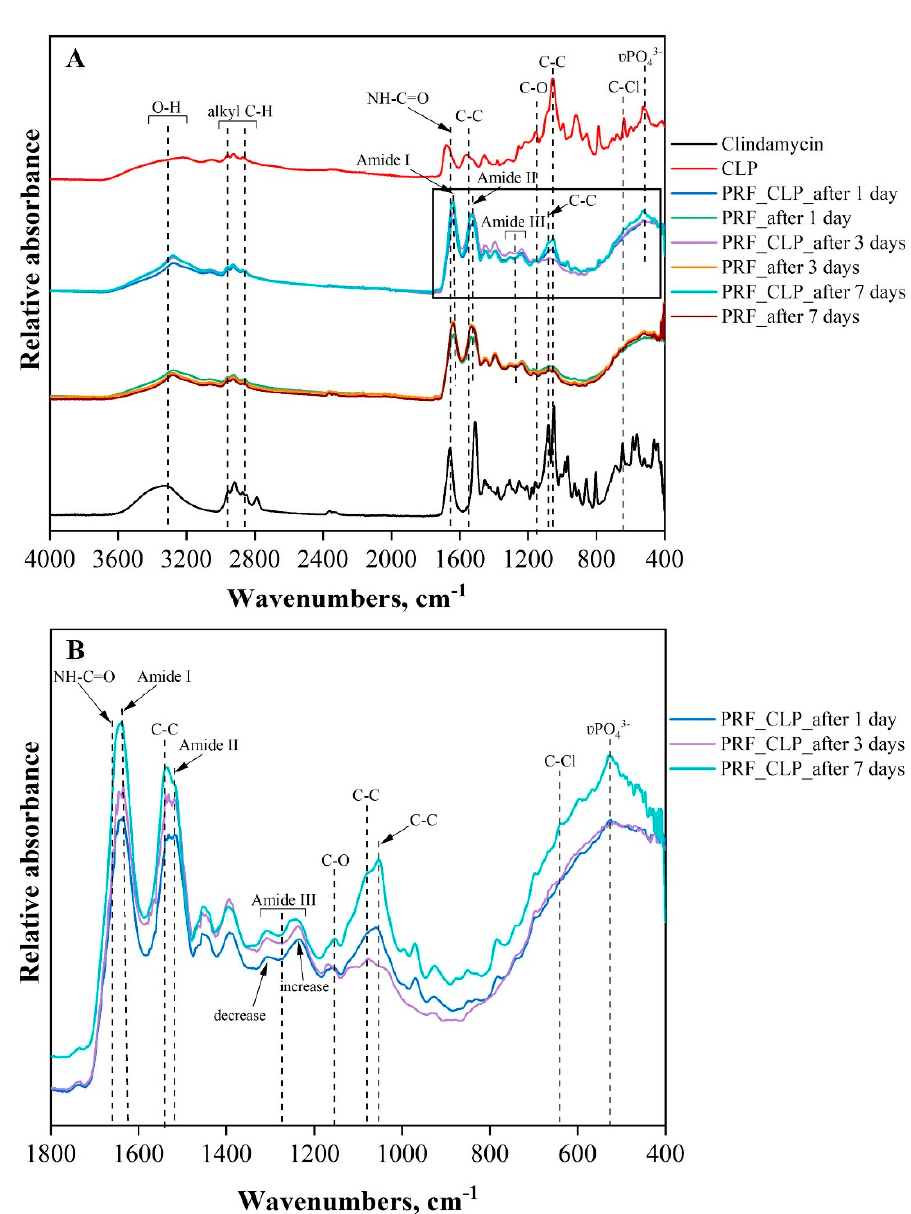
Figure 2. FTIR spectrum: ( A ) Full spectrum of absorption peaks PRF, PRF_CLP samples, CLP and clindamycin; ( B ) FTIR spectrum of PRF_CLP samples at incubation time clindamycin; ( B ) FTIR spectrum of PRF_CLP samples at incubation time points.